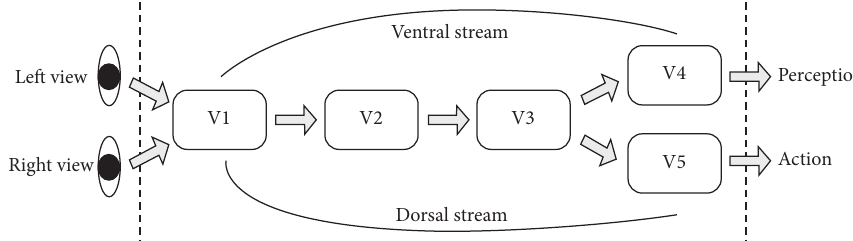
Figure 1: A simplified illustration of visual cortex with ventral stream and dorsal